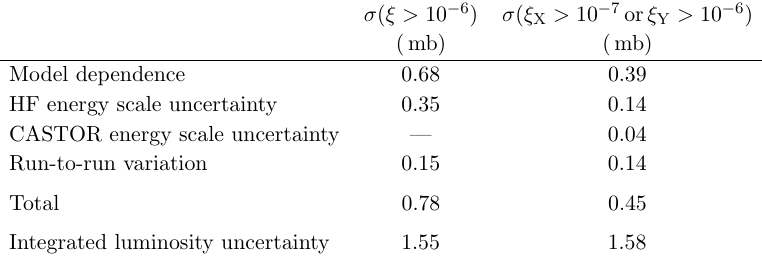
Table 2 . Overview of systematic uncertainties from various sources that contribute to the cross section uncertainty in the two phase space regions considered in this